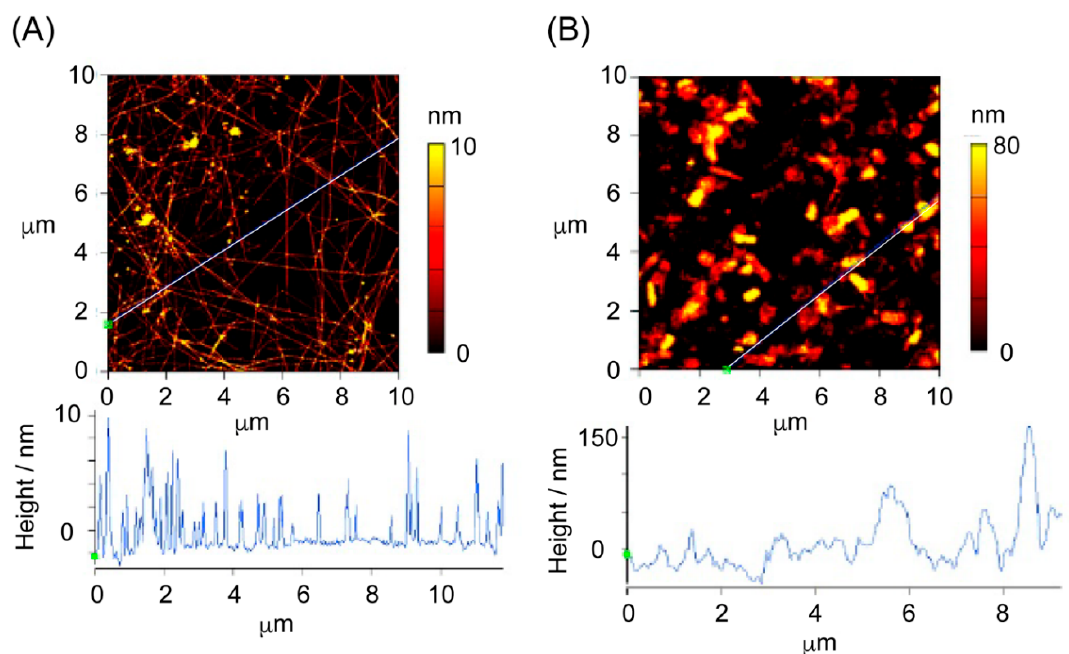
Figure 4. Atomic force microscopy (AFM) images of RU003 in the ( A ) absence and ( B ) presence of Ape5-TD incubated in water at 40 °C for 5 days (conditions: [RU003] = 100 µM and [TD] = 10 µM). Top and bottom panels indicate tapping mode AFM images and section analysis of the samples, respectively.